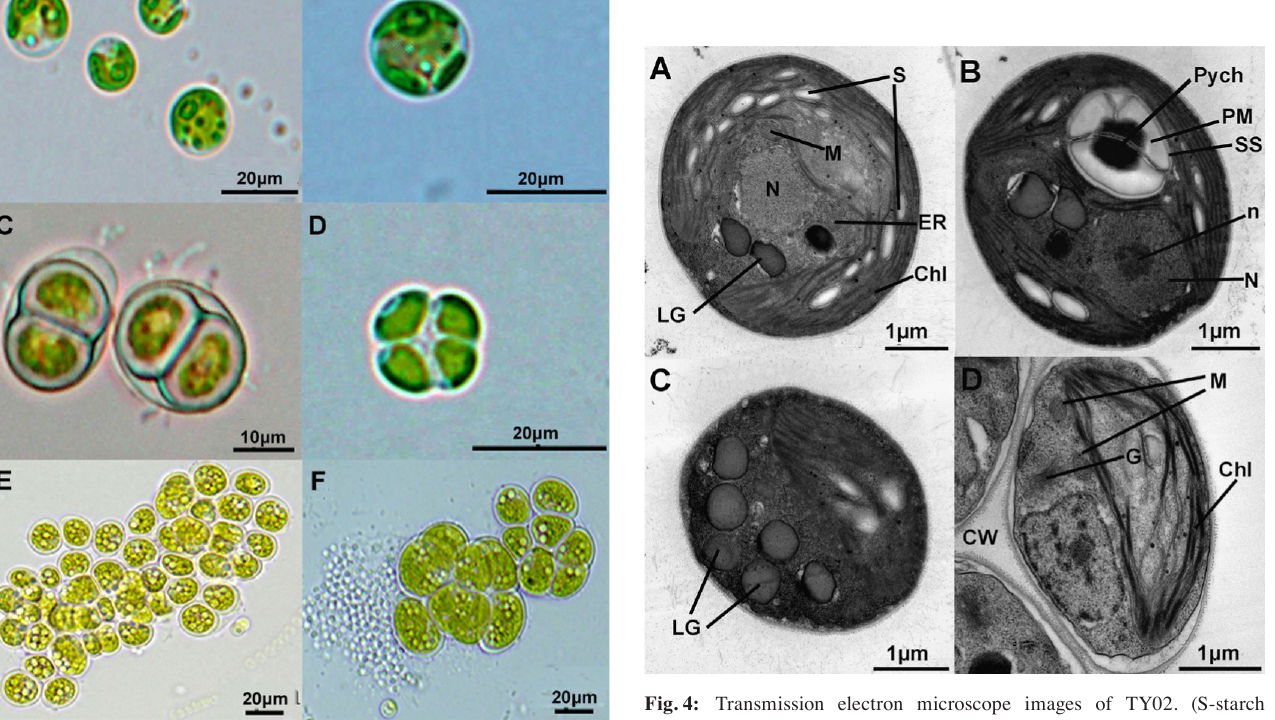
Fig. 3: Scanning electron microscope images of TY02. (A) unicellular, (B- D)